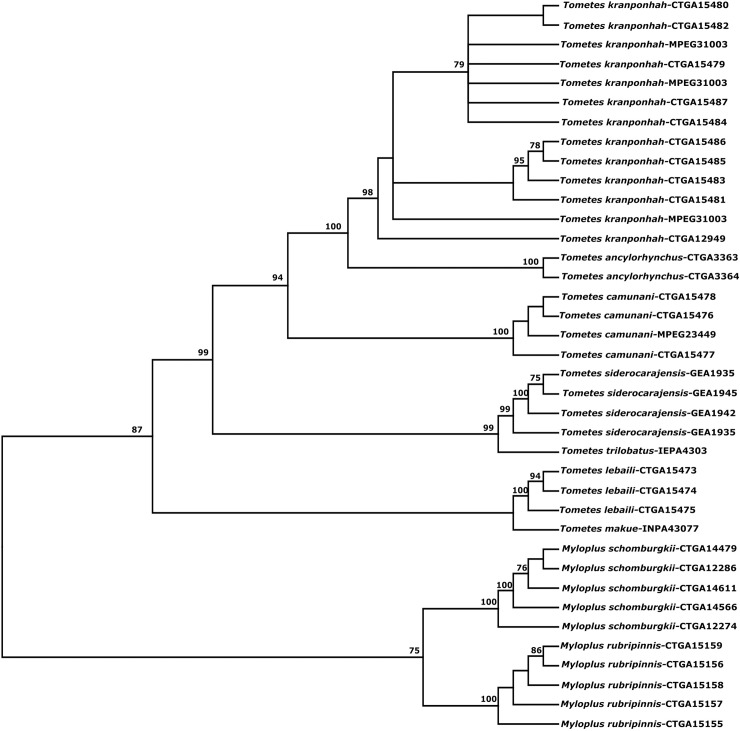
Maximum Likelihood tree inferred in RAxML using the concatenated data matrix of two mitochondrial genes (COI and Control Region), showing phylogenetic relationships within the genus Tometes genus.The numbers above branches are bootstrap probabilities > 50%. Myloplus schomburgkii and Myloplus rubripinnis were used as outgroups.